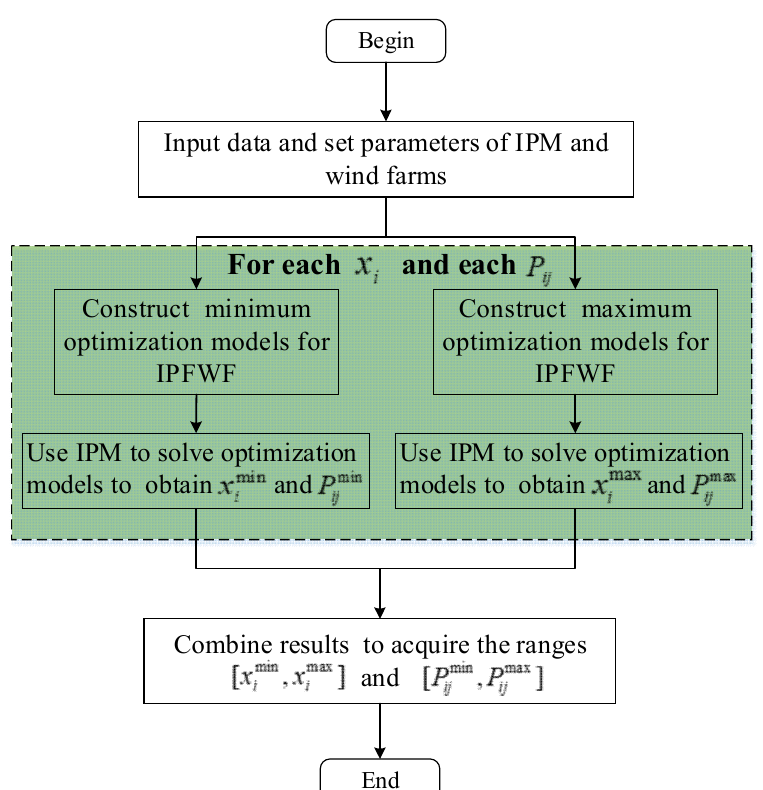
Figure 5. Solution process of solving the interval power flow considering wind farm (IPFWF) model based on the optimizing-scenarios method (OSM).